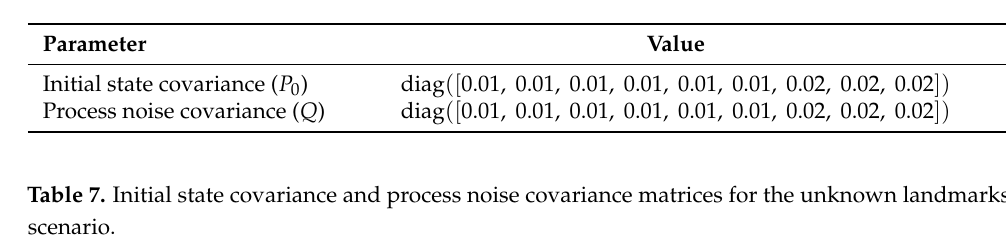
Table 6. Initial state covariance and process noise covariance matrices for the known landmarks scenario.